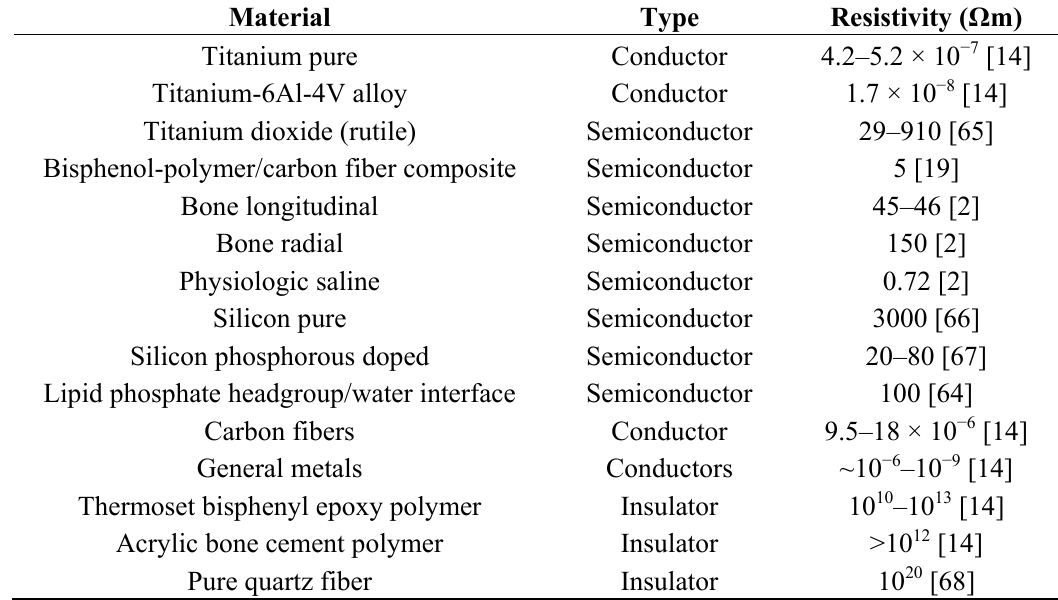
Table 2. Resistivity a of different engineering and biological